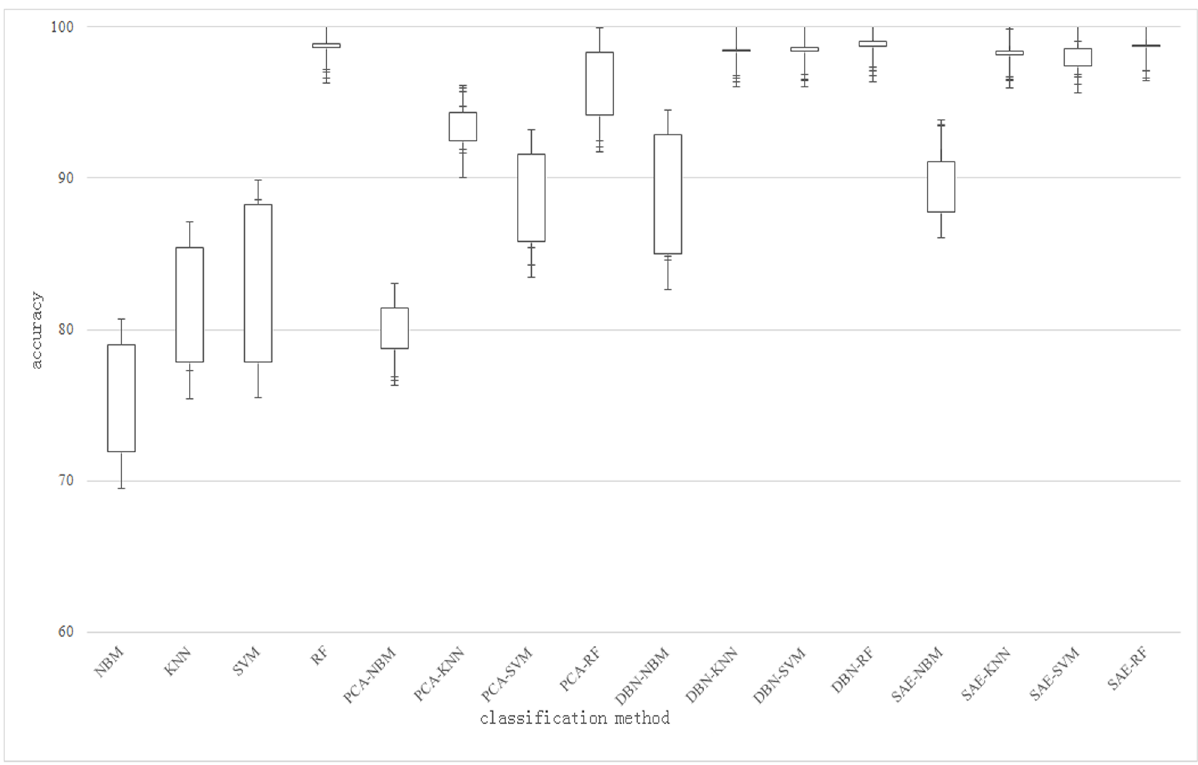
Fig 14. The statistics of the different algorithms. For a more intuitiverepresentation of the classification algorithm, the box shapedfigure of classificationalgorithmmodel of accuracy is as shown in Fig 14, which is the statistics of four groupsof different numberof trainingset and test set showingthe accuracy of classificationwhich is before and after using dimensionreduction. In Fig 14, we also can directly see the random forest algorithmhas excellent classification performance, comparedto other